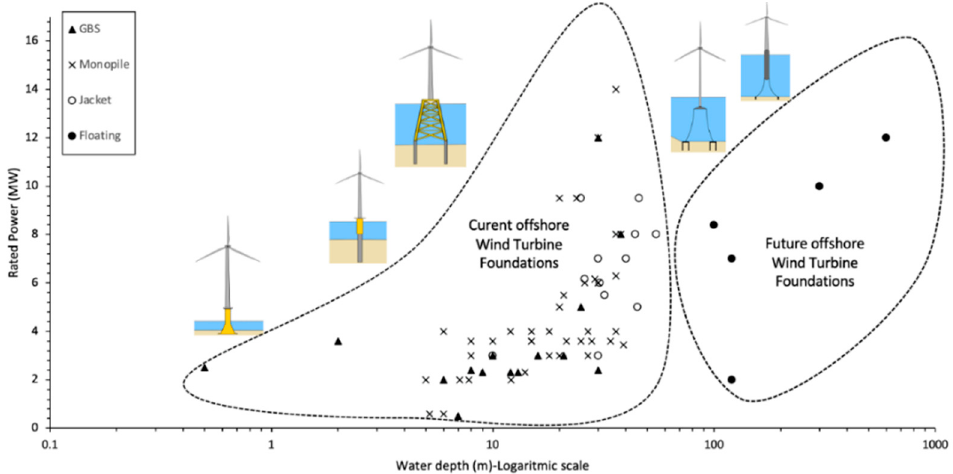
Figure 4. Proposed and existing foundation types for different water depths.